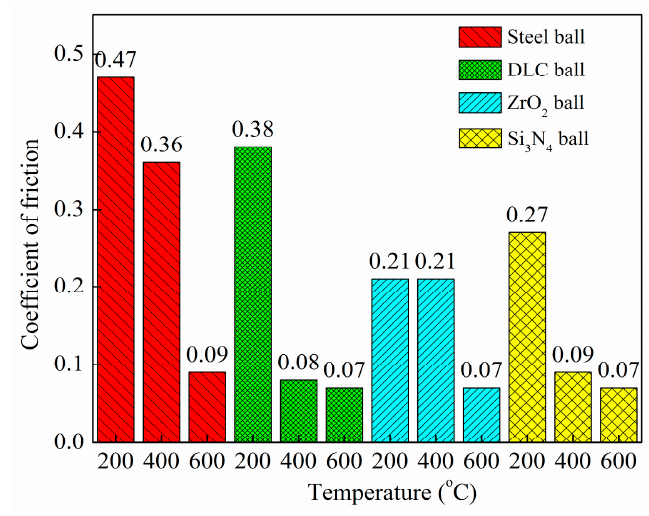
ff erent friction pair materials and Figure 12. CoF of different friction pair materials and temperatures. Figure 12. CoF of di